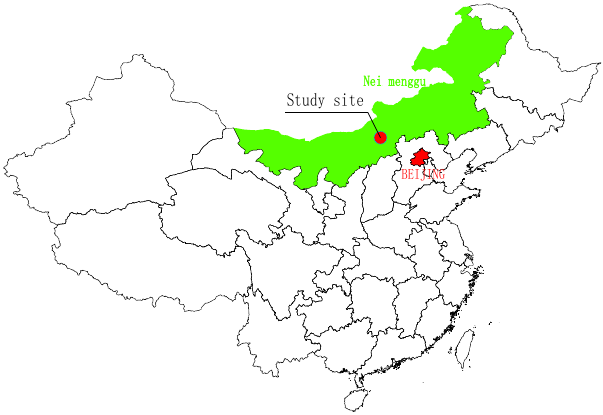
Figure 2. Geographical location of the study